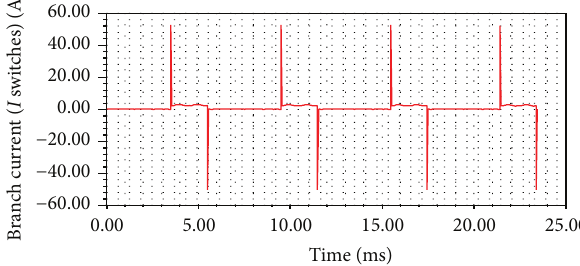
Figure 20: The current waveform of a switch (with LCL filter and capacitor